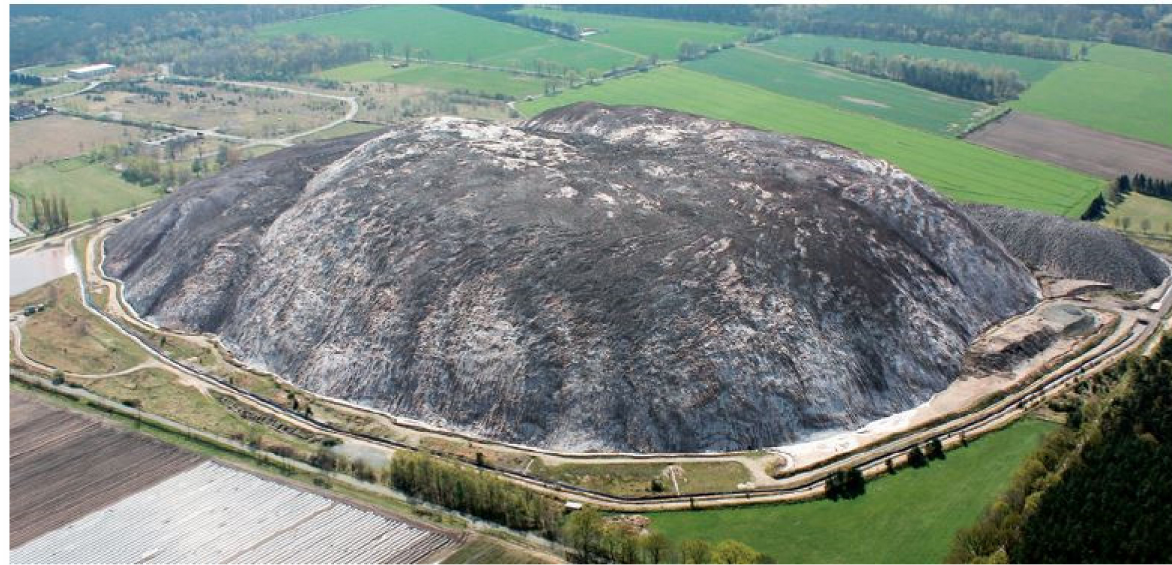
Figure 17. Salt dump Wathlingen, about 30 km NE of Hannover/Germany, in the early stage of recultivation [70], with the permission of K + S Baustoffrecycling